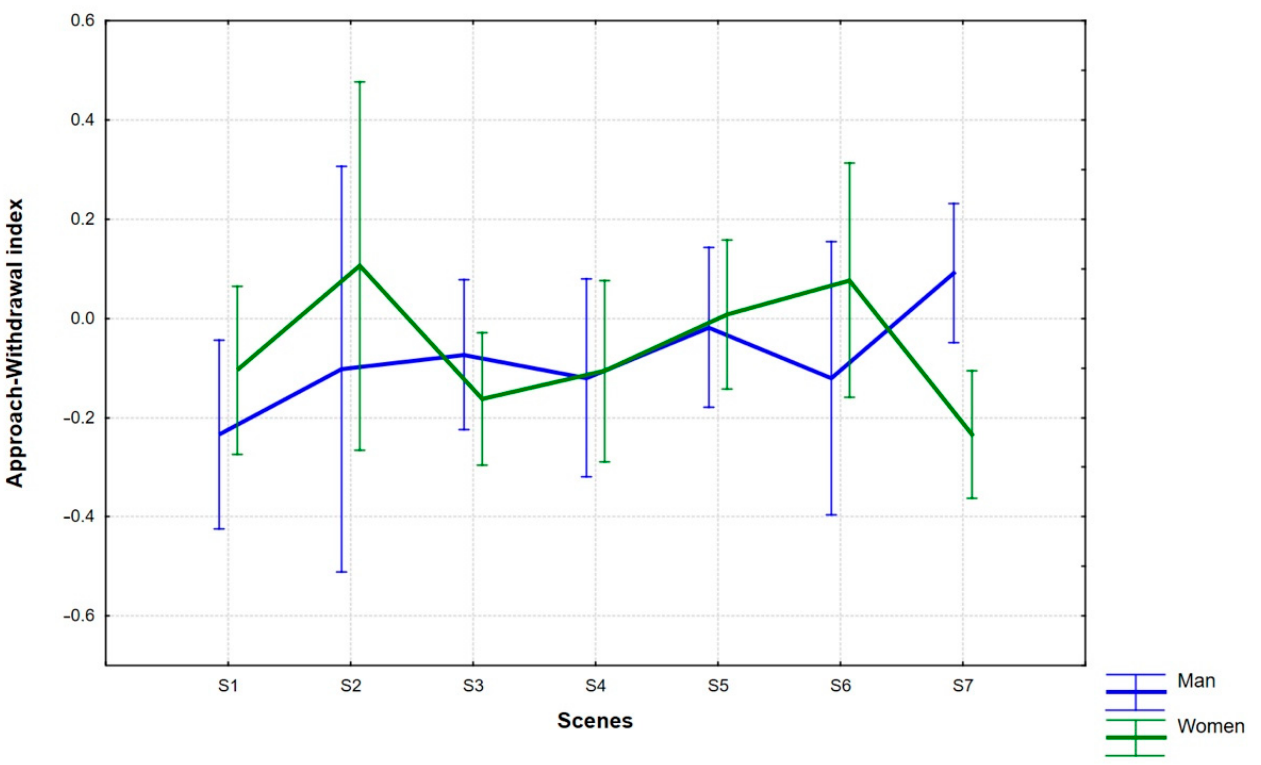
Figure 3. Differences in mean AW index values between men and women for scenes under study. The highest mean AW values were obtained by women for S2 (M = 0.11) and S6 (M = 0.08), and the lowest for S7 (M = − 0.23). As regards male participants, the scene with the highest mean AW index value was S7 (M = 0.09), while for S1 the index was the lowest (M = − 0.23). Post hoc analysis (Fisher F-test) showed that the only statistically significant difference for this interaction effect was obtained when comparing the mean index values of GENDER factor regarding S7. Here, the male participants (M = 0.09, SE = 0.07) achieved higher AW values than the female group (M = − 0.23, SE = 0.07). For the other scenes,